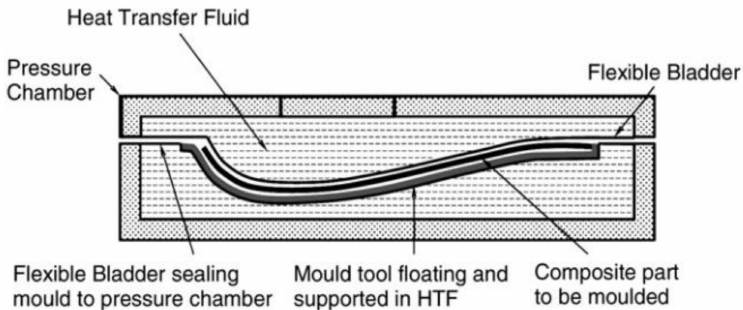
Figure 10. Schematics of the Quickstep Process [87]. Reprinted with permission from Elsevier.